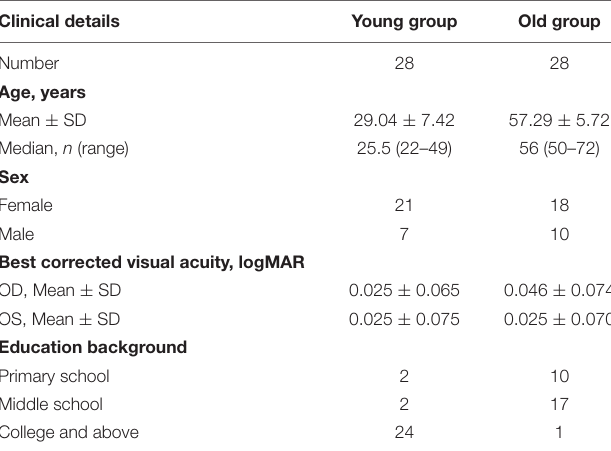
TABLE 1 | Clinical information of both groups, including age, sex, best-corrected visual acuity, and education